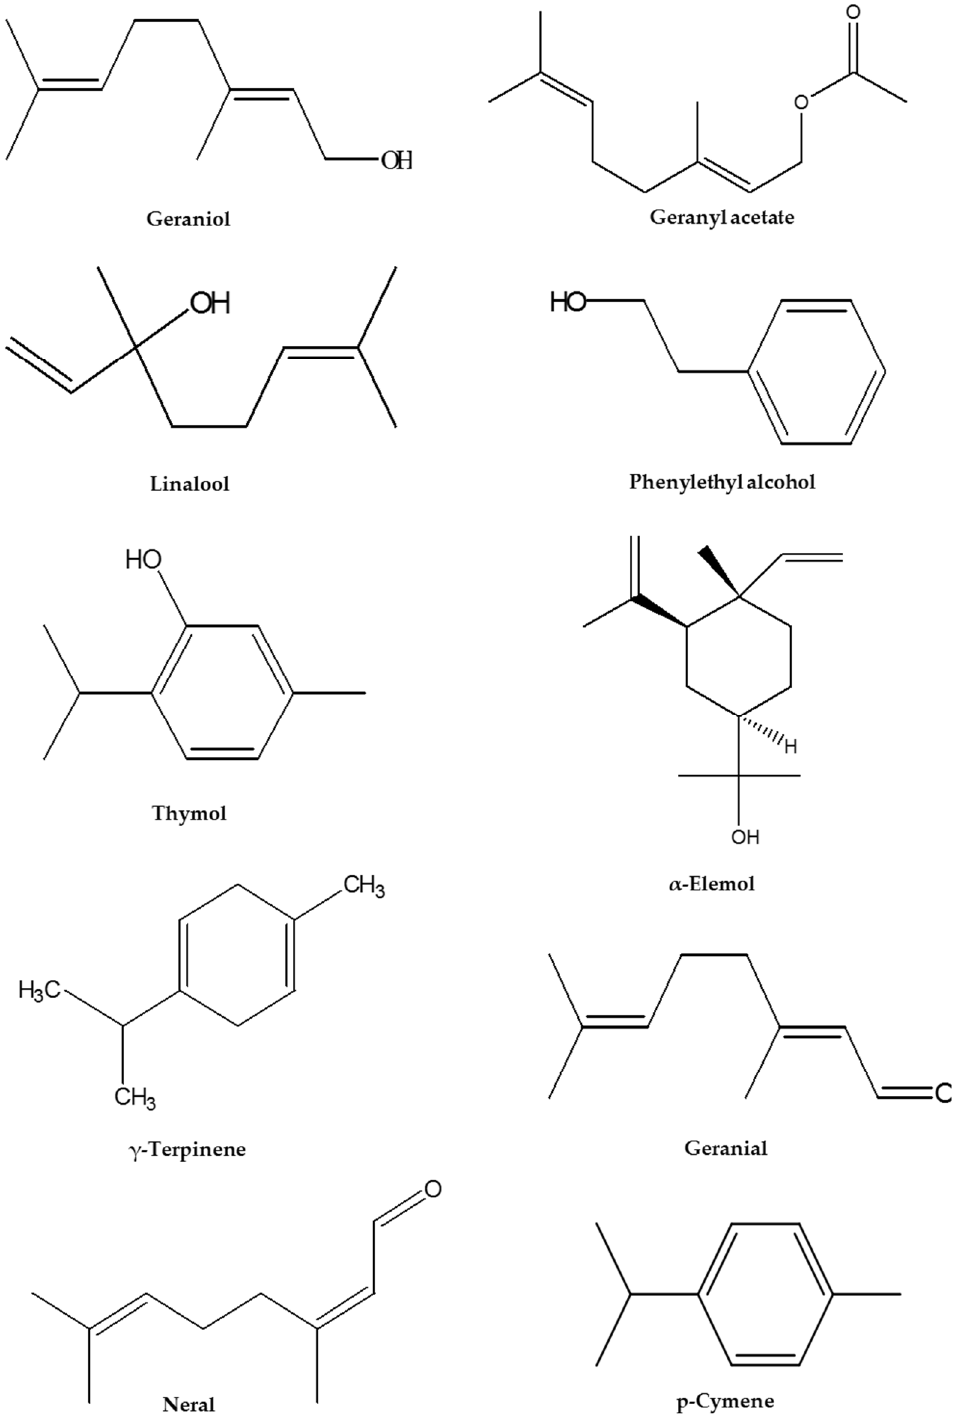
Figure 3. Structure of the major components identified in the essential oils of commercial Thymus vulgaris cultivars and Korean native Thymus quinquecostatus cultivars. Geraniol, geranyl acetate, linalool, phenylethyl alcohol, γ-terpinene, and thymol were identified as the major components, comprising >20% in at least one of the essential oil obtained from the different cultivars.